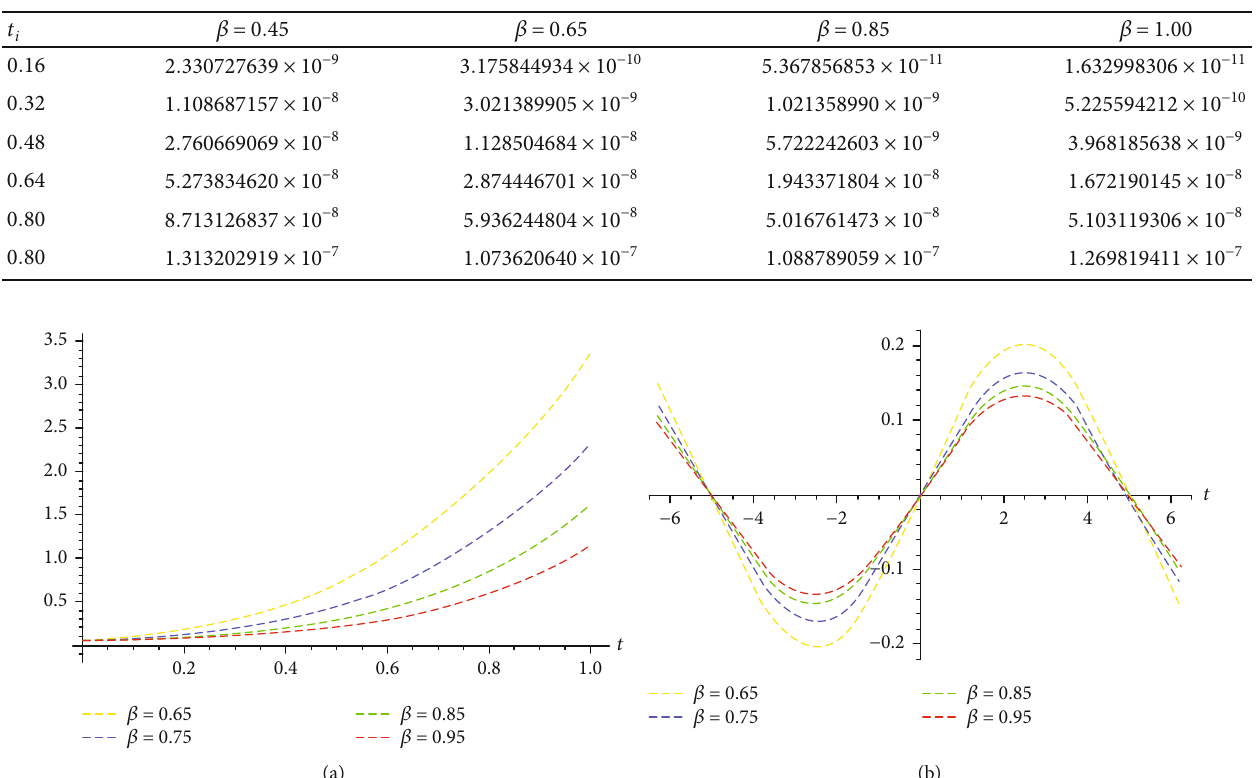
x , t Þ − w x , t Þj of the fi fth approximate solution with di ff erent values of β , for Example 5 ð 4 ð